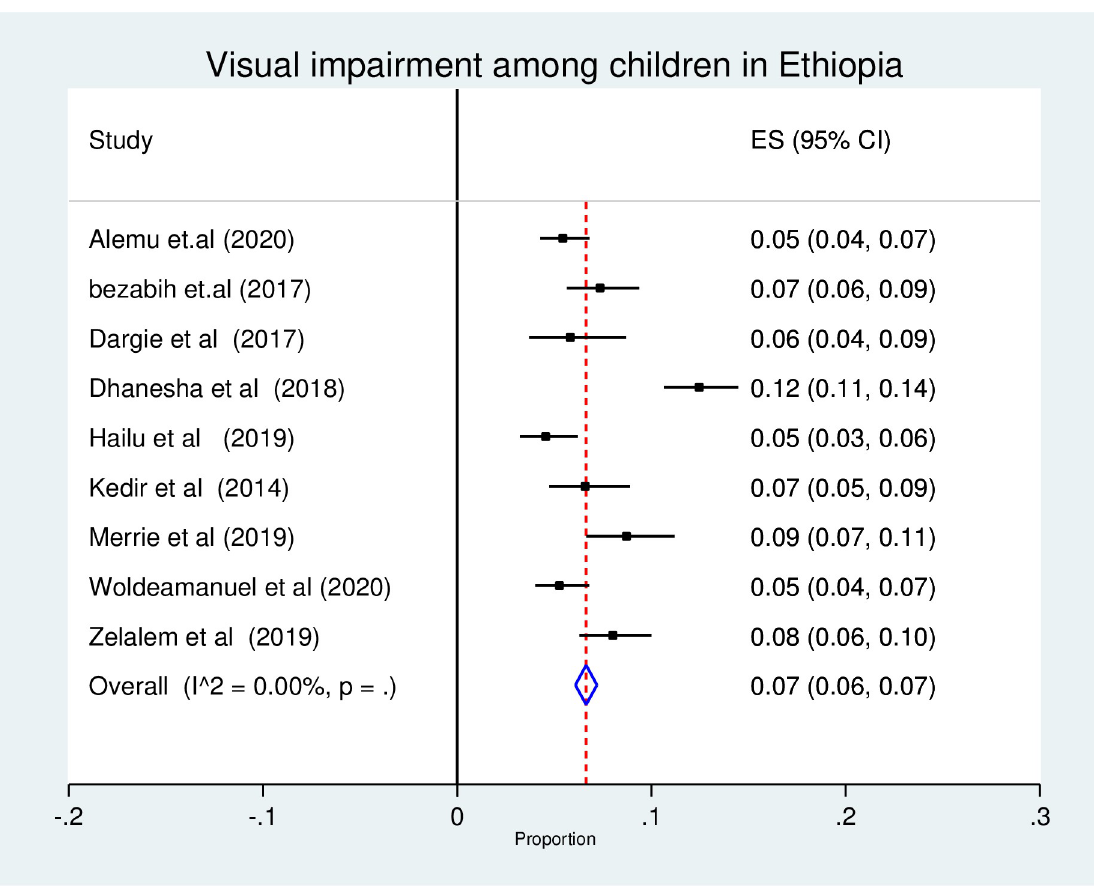
Fig 2. Forest plot of the pooled prevalence of visual impairment among children in Ethiopia,